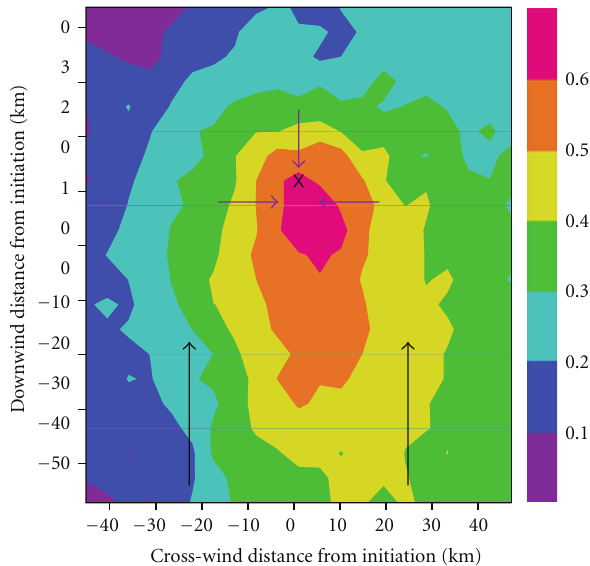
Figure 5: Favoured location (X) for initiation of convective storms [77]. Storms tend to develop over locally warm surfaces (shading denotes land surface temperature anomalies (K) based on a composite of nearly 4000 cases), but close to wetter (cooler) soils downwind. Arrows in mauve and black denote, respectively, the surface-induced, and large-scale components of the